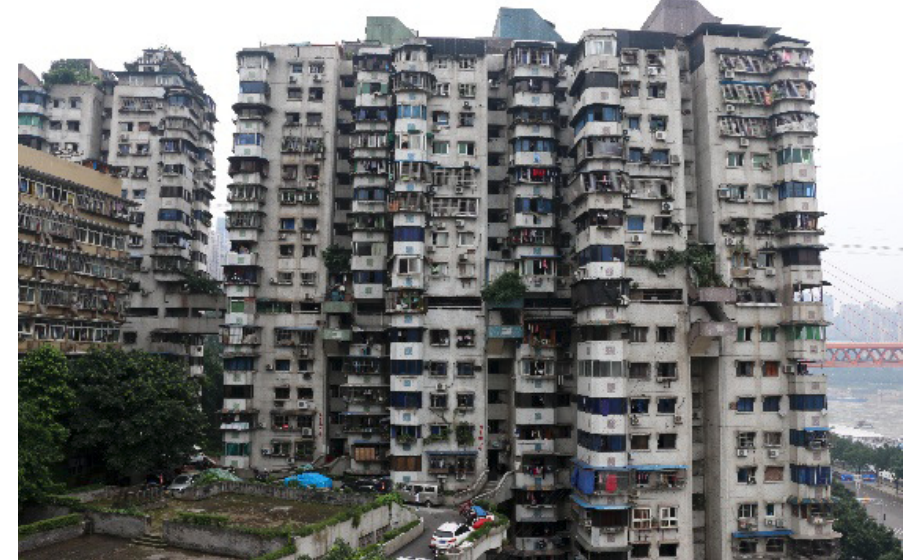
Figure 4. Baixiangju residential complex. lifts in the city centre of Chongqing, similar to Baixiangju, have two or even more entrances on different storeys, each leading to different streets on different levels. they are and where their flats lie. This mode provides the staircases of these buildings with a unique